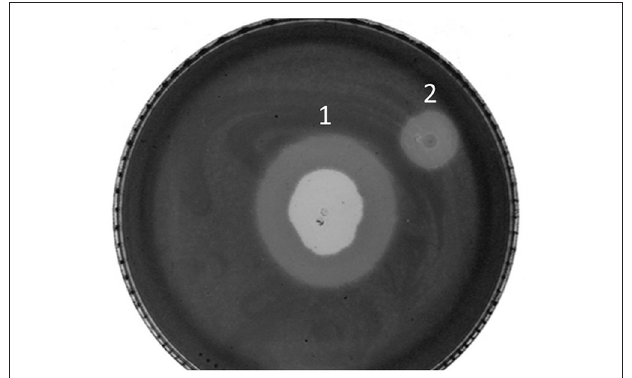
FIGURE 7 | Plaque and halo formation on A. baumannii 6077/12. (1) Zone of lysis and halo after spotting ISTD phages on bacteria in exponential growth phase, (2) halo after spotting ISTD phages on bacteria in stationary growth phase.